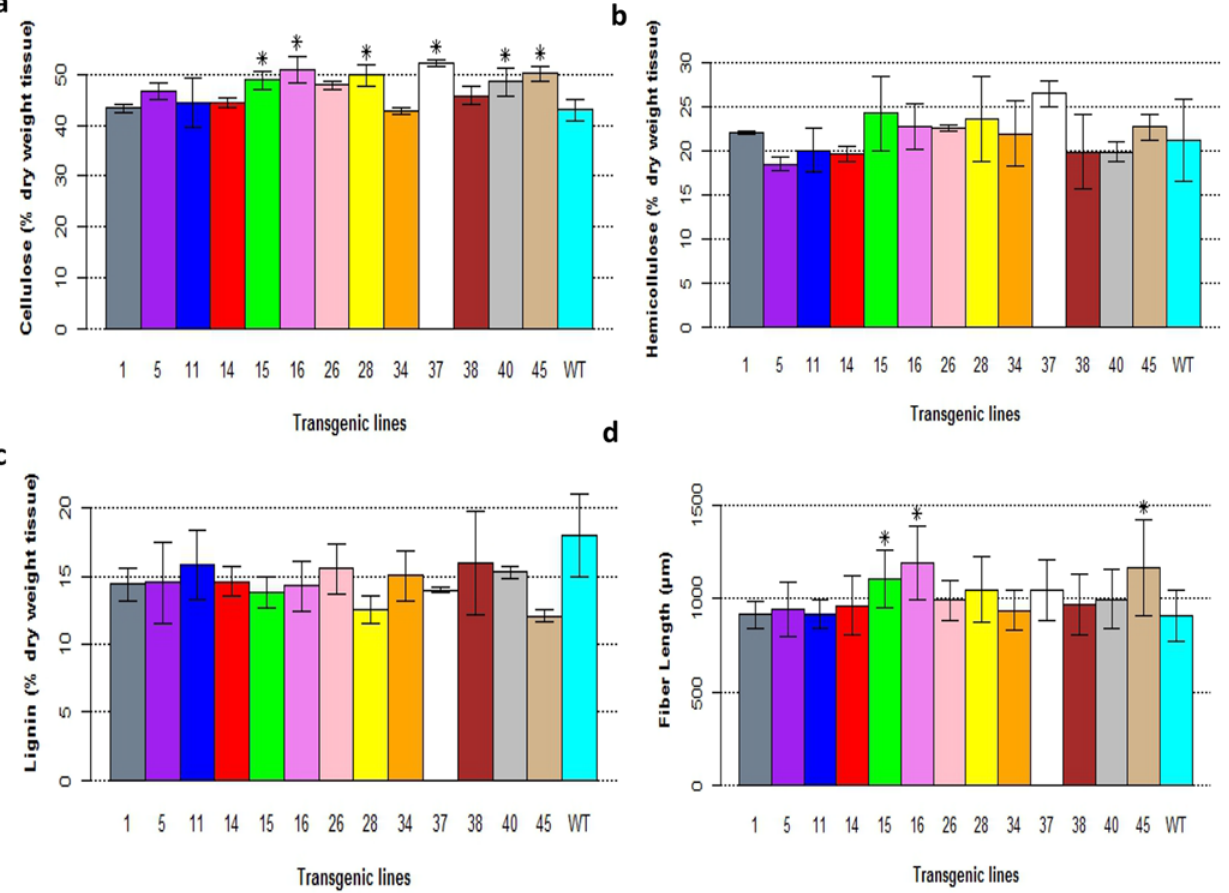
Fig 8. Changes in lignocellulosic components in PsnSusy2 tobacco transgenic lines. a. Cellulose contents in the plastichron index (PI) 5~8 stem tissues of three-month-old PsnSusy2 transgenic tobacco lines. b. Hemicellulose contents in the PI5~8 stem tissues of three-month-old PsnSusy2 transgenic tobacco lines. c. Lignin contents in the stem the PI5~8 stem tissues of three-month-old PsnSusy2 transgenic tobacco lines. d. Fiber length in the PI5~8 stem tissue of three-month-old PsnSusy2 transgenic tobacco lines. All measurements are the means of five different samples ± S.E. The t -test was used to examine the significance of difference between PsnSusy2 transgenic and wildtype lines, and * denotes significance at p < 0.05. The WT represents wildtype tobacco plants, whereas all the others are different PsnSusy2 transgenic lines.